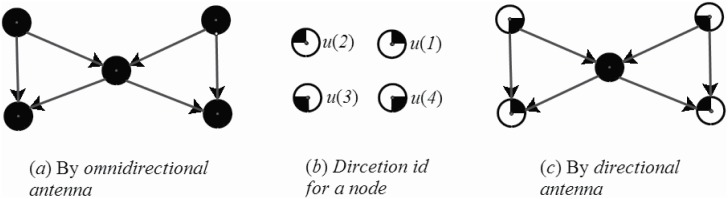
The omni-antenna graph and direction antenna graph.